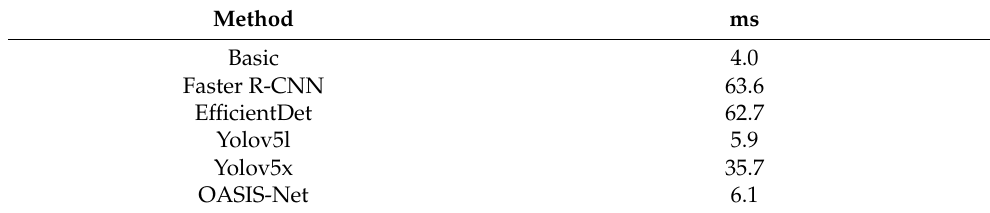
Table 4. Comparison of inference time of box-level detection-based methods.